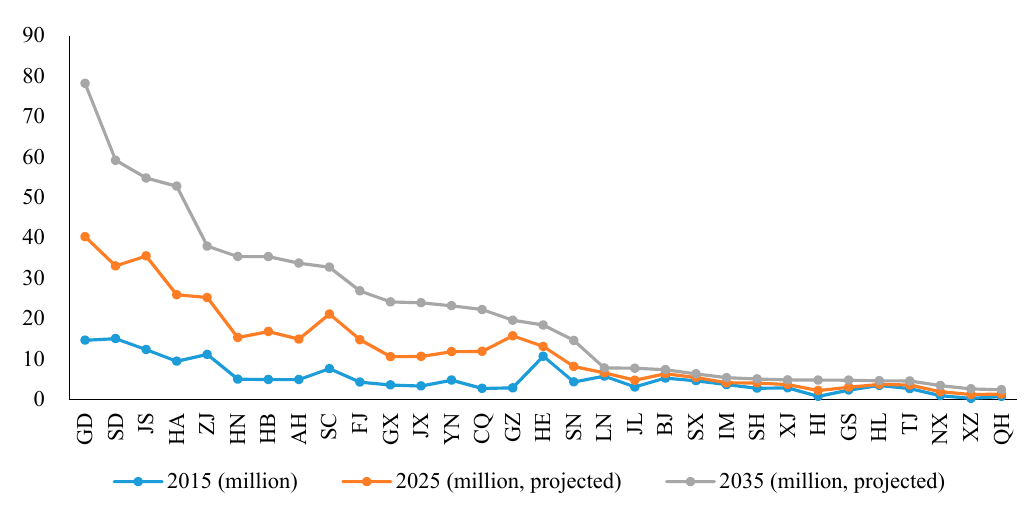
Figure 5. Provincial projections of vehicle ownership in 2035.